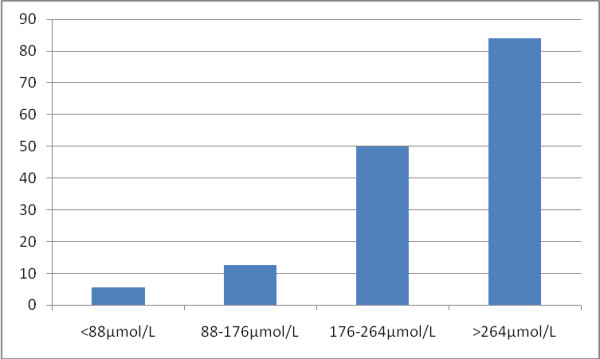
Proportion who should have received RRT by admission serum creatinine.